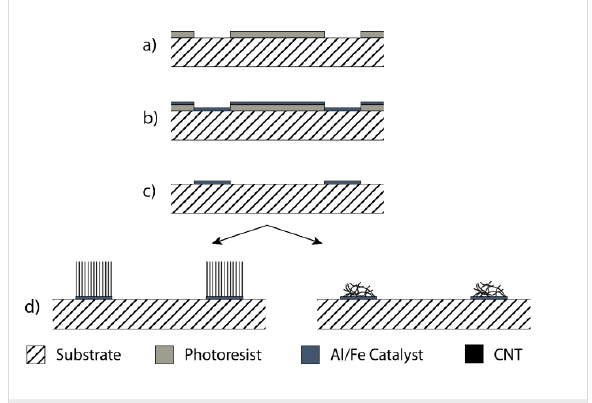
Figure 1: General scheme for the fabrication of spatially deposited CNT islands. (a) A photoresist is lithographically structured; b) defined aluminium and iron layers were evaporated onto the substrate. After removing the photoresist the catalyst islands of bimetallic Al/Fe are spatially structured on the silicon substrate. (d) The follow up growth of CNTs proceeds selectively on these spatially defined catalyst islands in a vertically aligned fashion on the Si substrate (left side), or in a randomly oriented fashion on an Au substrate (right